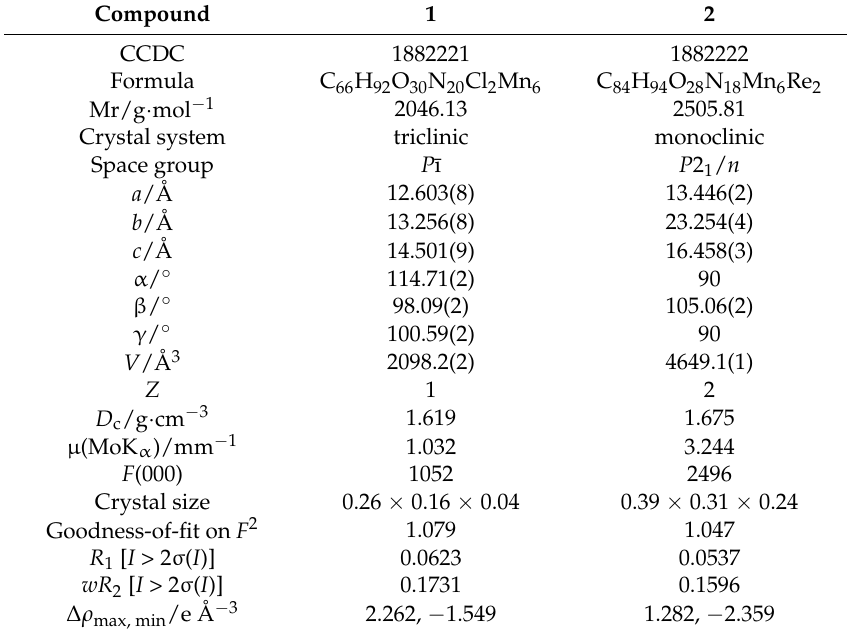
Table 1. Summary of the crystal data and structure refinement for 1 and 2